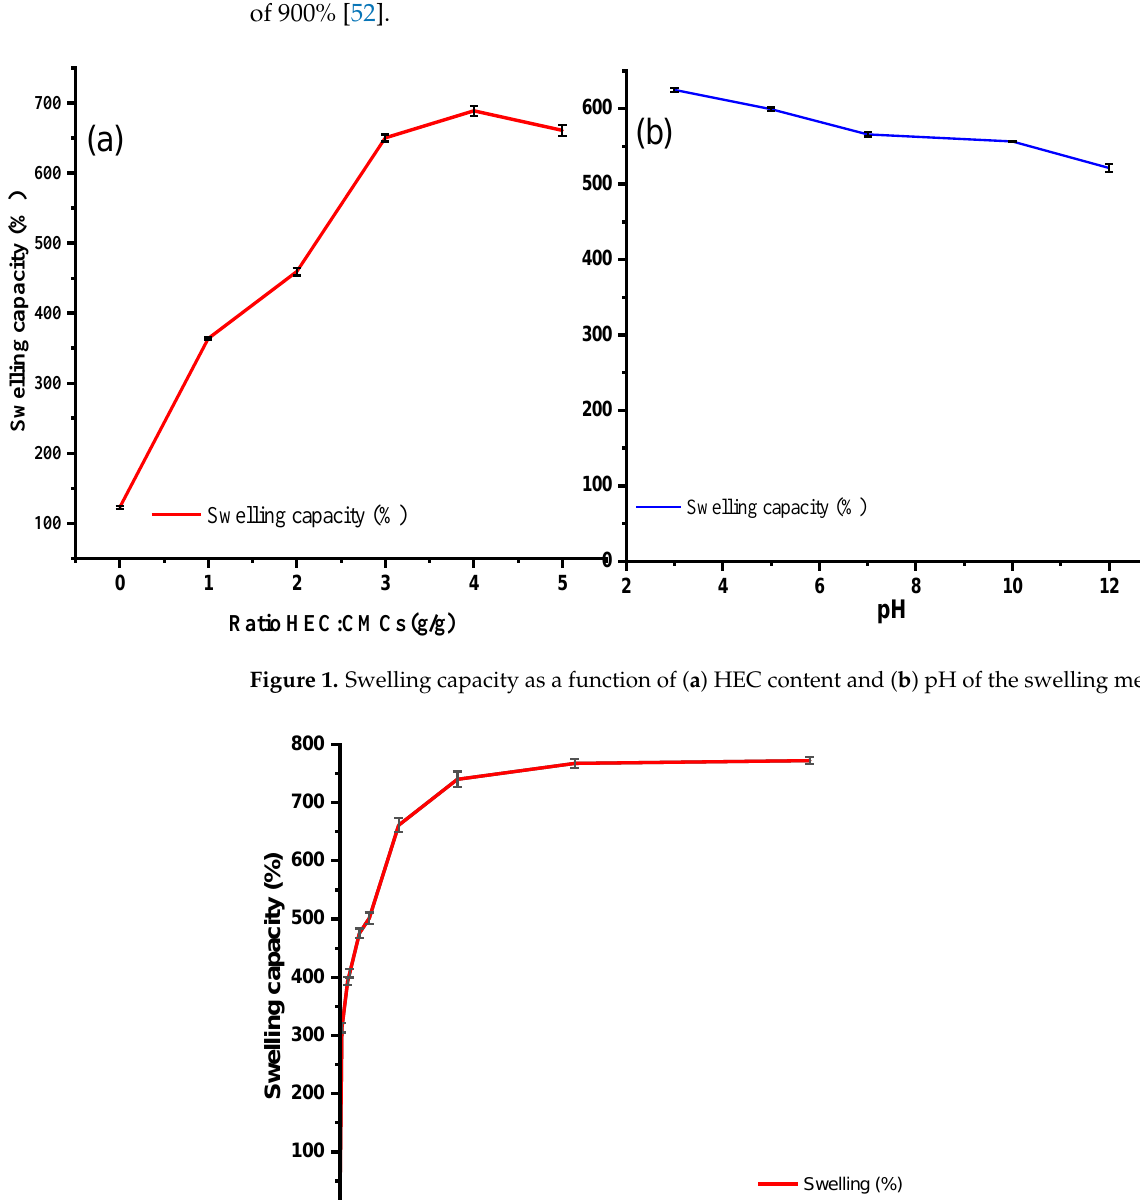
when crosslinked with divinyl sulfone, CMC and HEC have been reported to have a